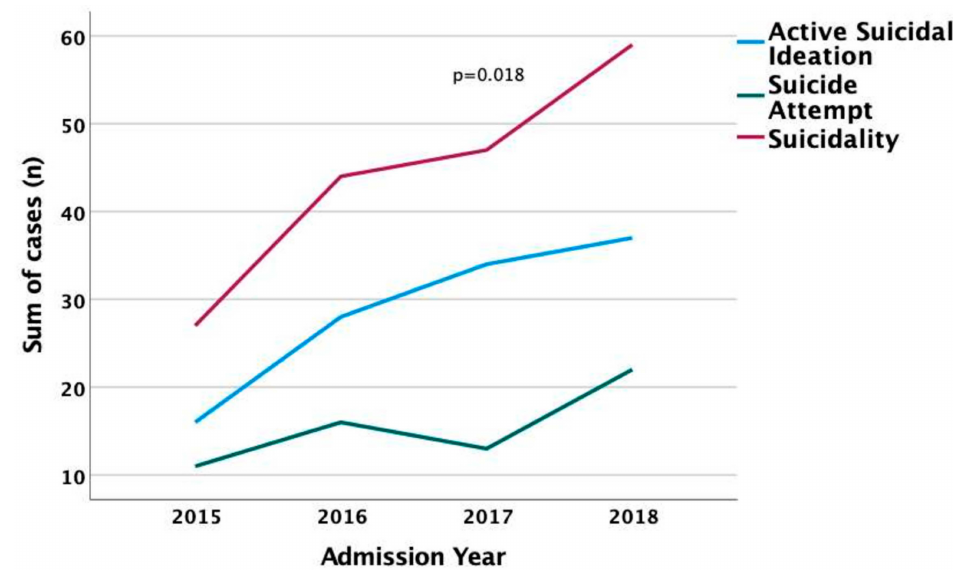
Figure 3. Suicidality, suicidal ideation, and suicide attempt annual rates during the 4-year study period. In a logistic regression model (backward stepwise (Likelihood Ratio) method), the